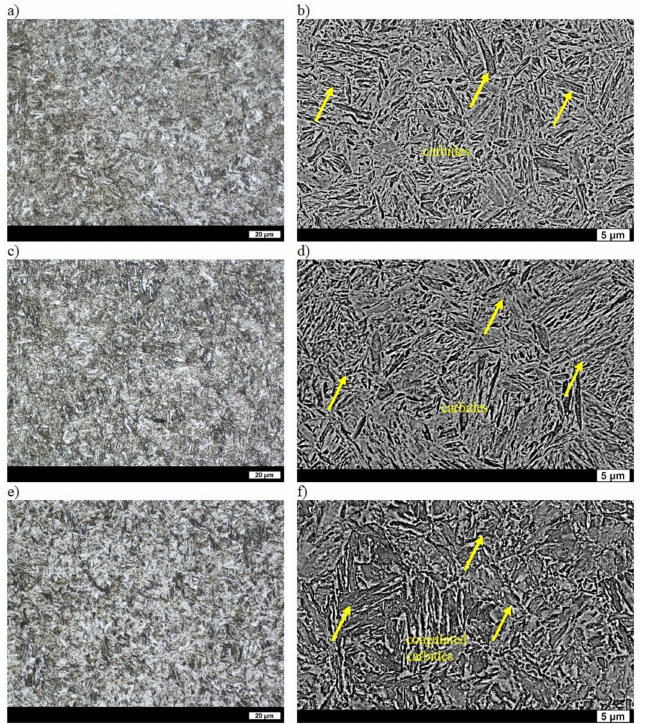
Figure 7. Microstructure of ingot No. 5 after quenching and tempering: ( a ) at 200 ◦ C, LM; ( b ) at 200 ◦ C, SEM; ( c ) at 400 ◦ C, LM; ( d ) at 400 ◦ C, SEM; ( e ) at 600 ◦ C, LM; ( f ) at 600 ◦ C, SEM. Etched with 3% HNO 3